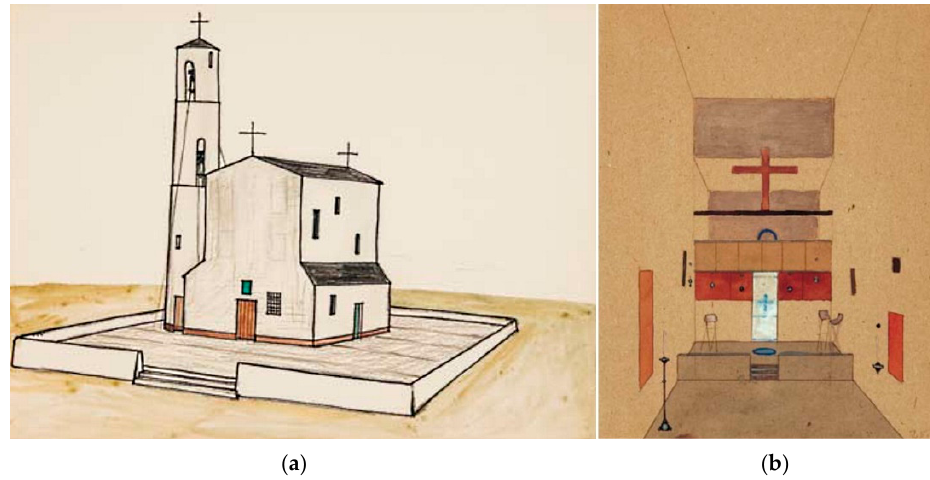
Figure 9. Jerzy Nowosielski: ( a , b ) sketches of imaginary churches from 1950. Photography by M. Gardulski/Galeria Starmach. Reproduced with permission.